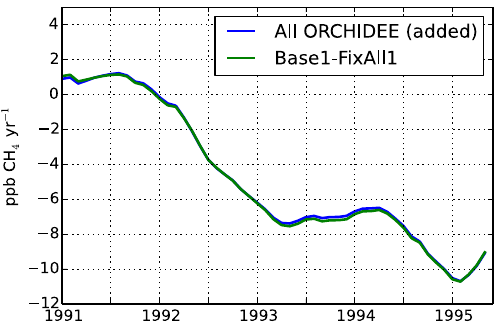
Figure B1. The combined effect of the seven drivers of CH 4 vari- ability on the global growth rate using ORCHIDEE emissions, as- suming additivity (blue) and from the difference between Base1 and